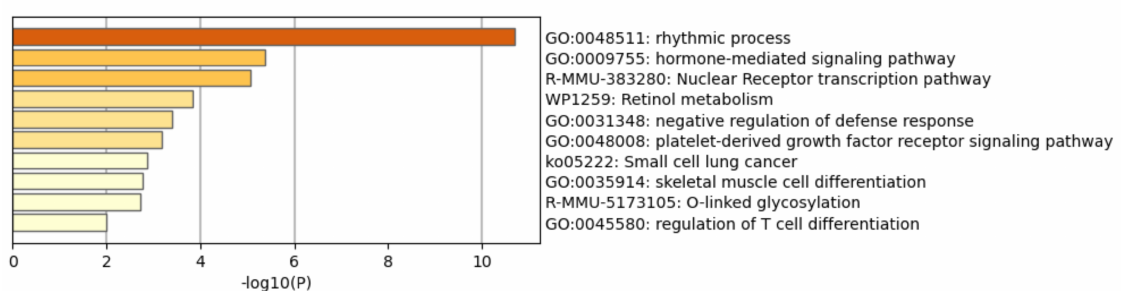
Figure 9. Metascape functional enrichment heatmap following the analysis of all 5% FDR-corrected DEGs (absolute FC ≥ 1.5, q-value < 0.05) after the exposure to 1 mg/kg bw /day of E171 in a Tg mouse model. Bar graphs of enriched terms across the input gene list are colored by p -values. Significantly altered genetic pathways included rhythmic processes, signaling, nuclear transcription pathway, retinol metabolism, negative regulation of defense responses, platelet-derived growth factor signaling, small cell lung cancer, skeletal muscle cell differentiation, O-linked glycosylation, and regulation of T-cell differentiation, confirming genetic alteration in pathways that were identified by ORA and STEM